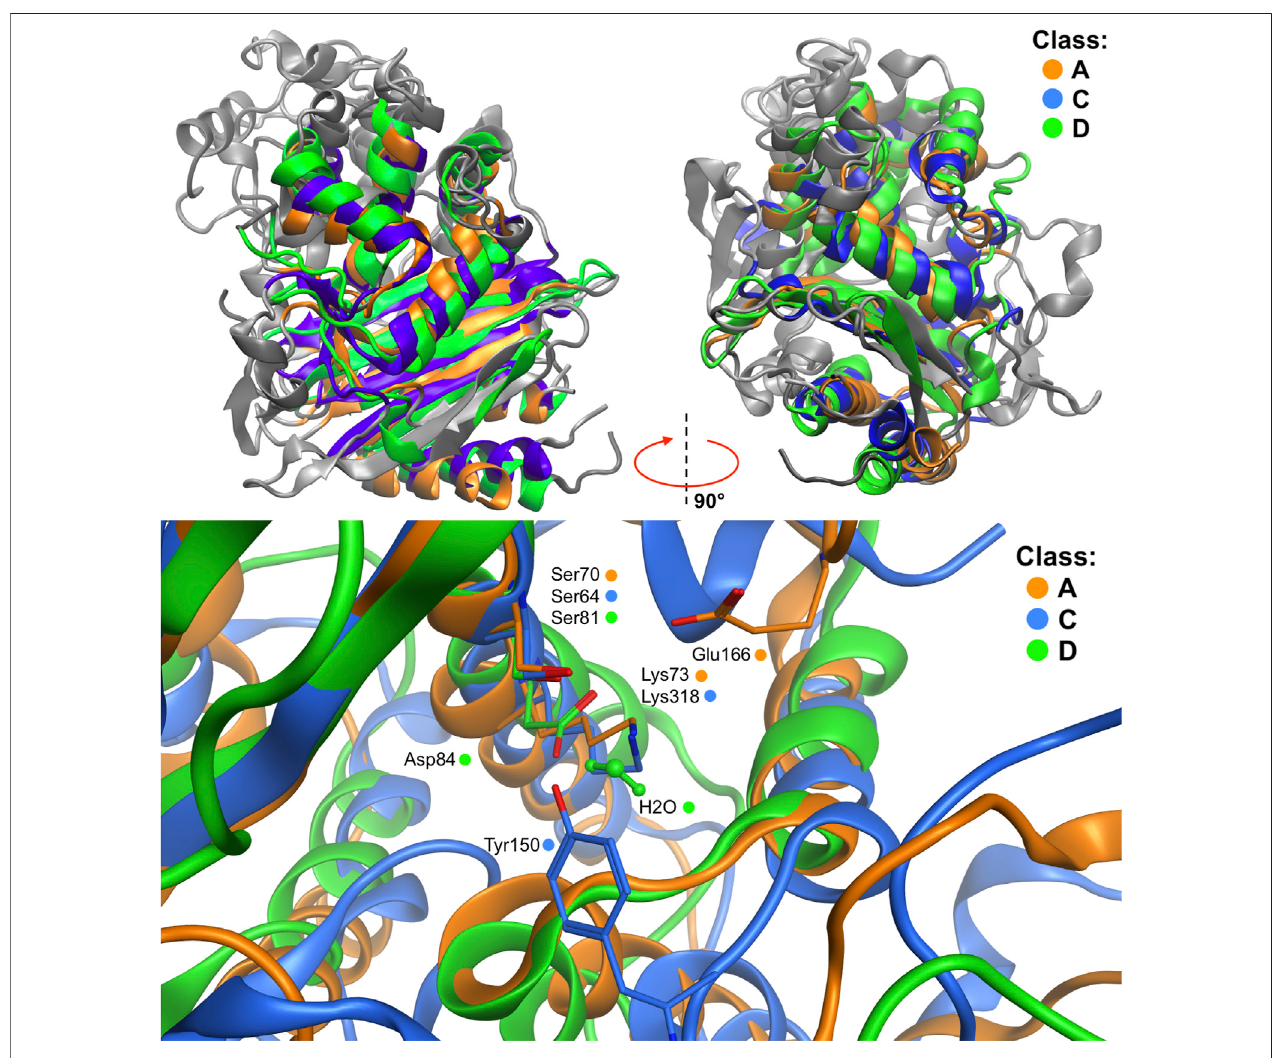
FIGURE5| Structuralmultiple-alignmentofthe β -lactamasesmembersfortheA(KPC-2 β -lactamase),C(CG1 β -lactamase),andD(OXA-24 β -lactamase)enzyme classes. Global alignment with two orientations (top) , and presentation of the active sites (bottom) resulting from the global alignment. Water residue in class D active site is depicted with balls and sticks representation. Residues crucial in the QM/MM simulations are presented as sticks.